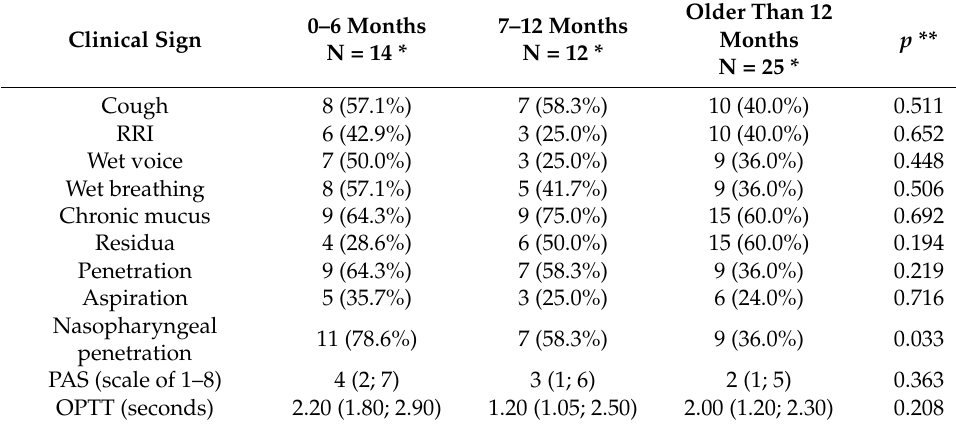
Table 7. Incidence of clinical signs depending on